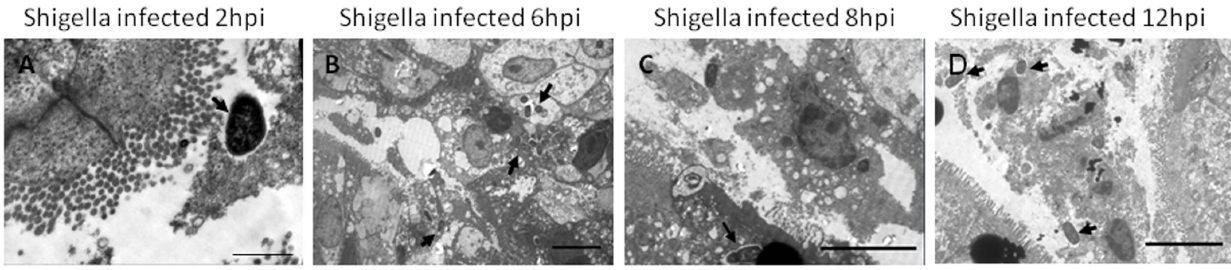
Figure 5. Transmission electron microscopy of the jejunum of one-day-old SPF chickens infected with the Shigella strain ZD02 via ligated intestinal loop. Shigella (arrowheads) were found near the epithelial cells at 2 h post-inoculation (A. Scale bar=1 m m). Internalized bacteria (arrowheads) in the epithelial cells were found at 6 h (B. Scale bar=5 m m) and 8 h (C. Scale bar=5 m m). The epithelial cells started to lyse and release bacteria (arrowheads) at 12 h (D. Scale bar=5 m m).